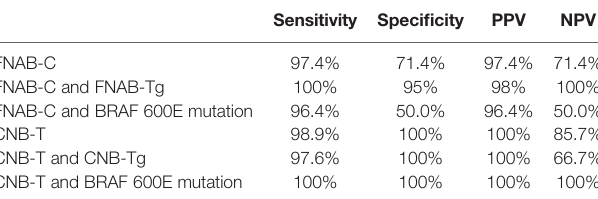
TABLE 4 | Diagnostic performance in FNAB-C and CNB-T combined with or without Tg in the wash-out or BRAF 600E mutation assessment.